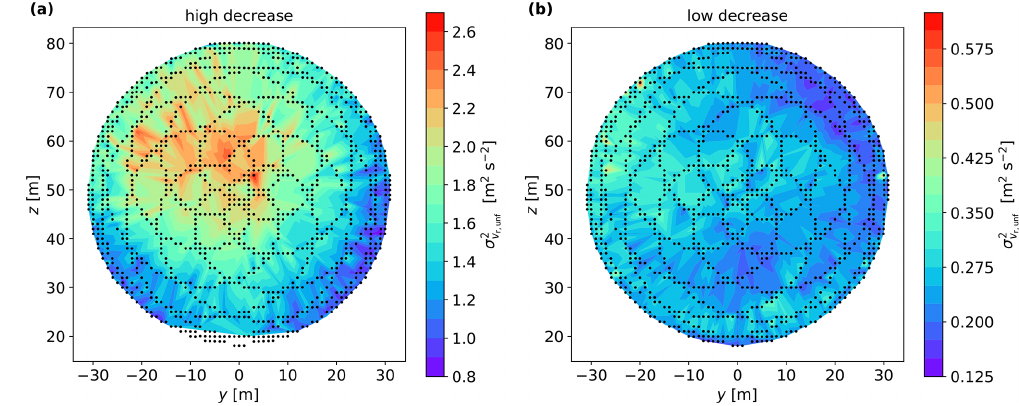
Figure 18. Contour plots of the radial velocity variance over the SpinnerLidar scanning pattern during two 10min periods, (a) a case with negative σ 2 v and σ 2 w values, (b) a case with σ 2 u ≈ σ 2 v > σ 2 w